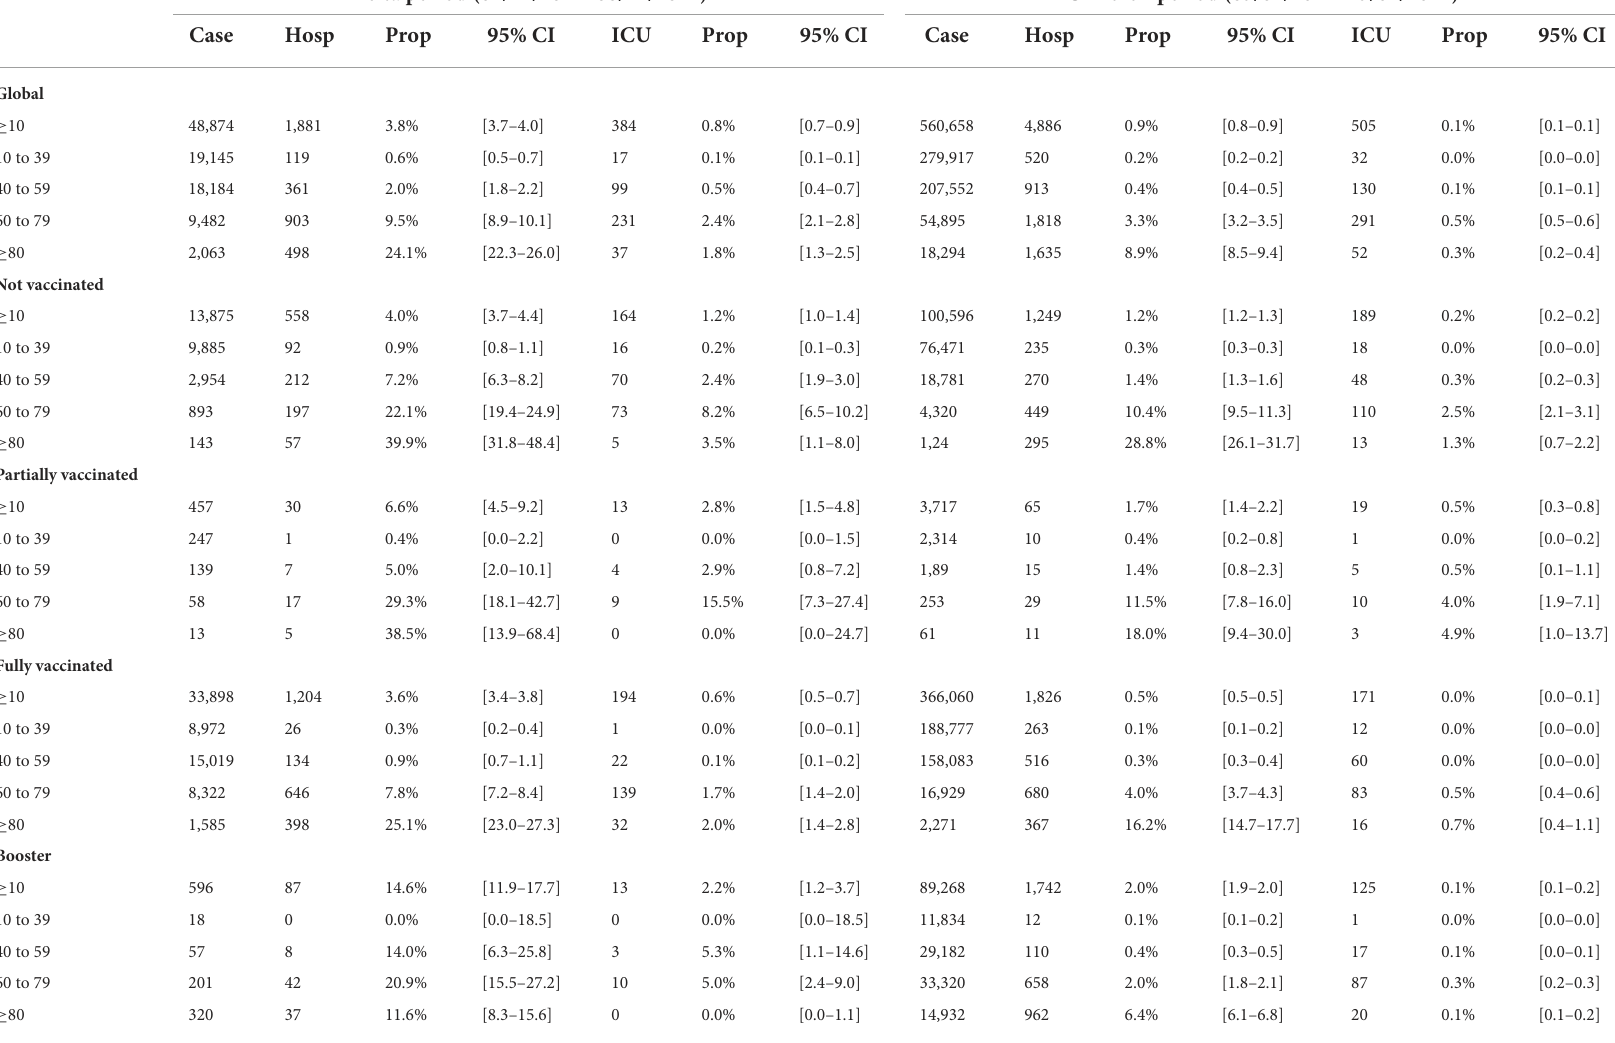
TABLE 2 Number of cases and hospitalizations and ICU admissions reported in each period, and percentage of cases with hospitalization and ICU admissions within 14